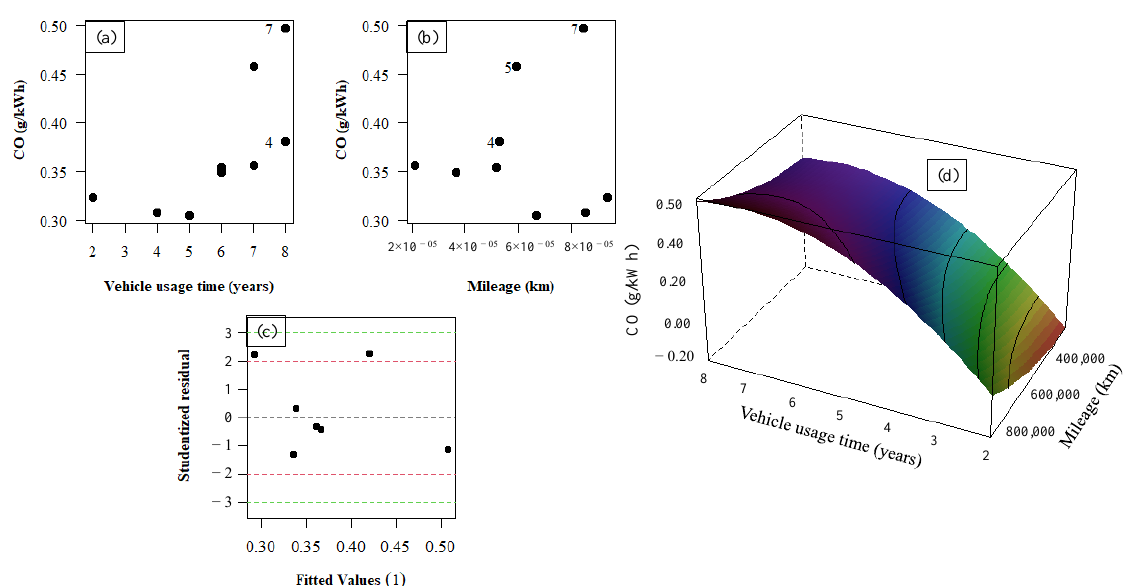
Figure 5. CO fugitive emission behavior—adjustments of mileage-time relationships using a degree-2 polynomial. ( a ) First individual fit using equation 6 with mileage as the explanatory variable. Samples 5, and 7 show high emissions rates; ( b ) Second individual fit using equation 6 with time of use as the explanatory variable. Similarly, samples 5, and 7 show high emission rates; ( c ) The third and last adjustment using all terms of the polynomial equation of degree 2 analyzed the correlation between the explanatory variables (mileage and time of use) brought improvements to the model; ( d ) The response surface shows an increasing trend in emissions with a higher degree for the time of use variable and a slightly increasing trend for